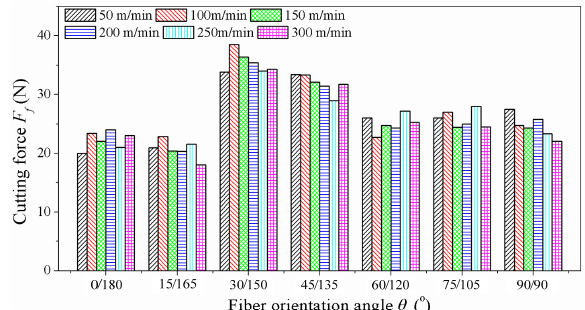
Figure 7. Cutting force results of PCD tool.